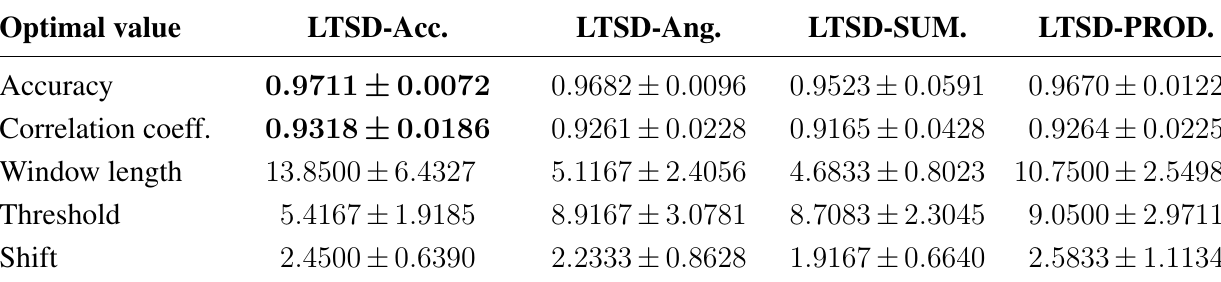
Table 9. Algorithms applied to real signals. Average Accuracy, Correlation coefficient and associated parameters (Long Term Spectral Detector).